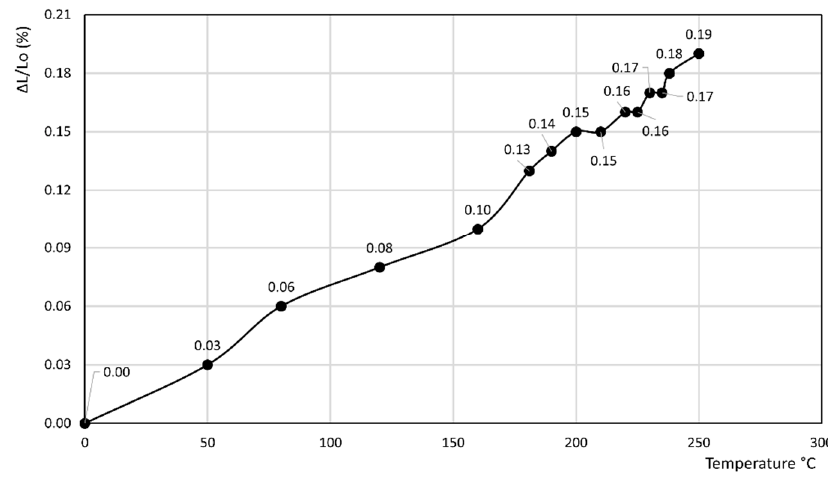
Figure 7. Thermodilatometric curve of rock 7, Gray Campanian Ignimbrite from Faicchio.